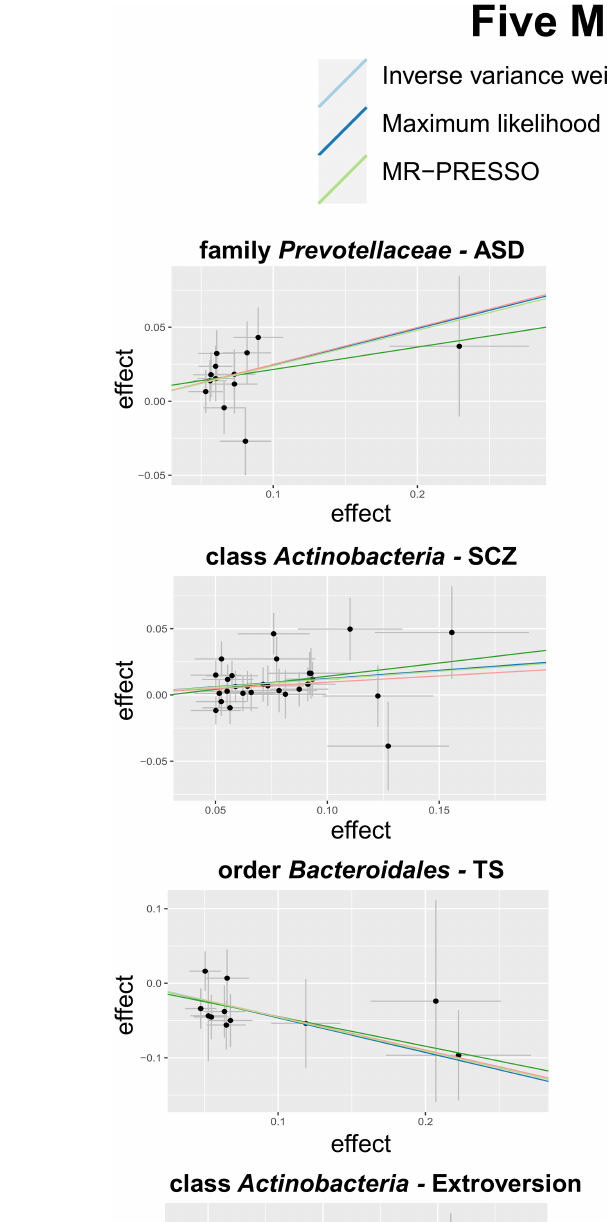
Frontiers in Microbiology |